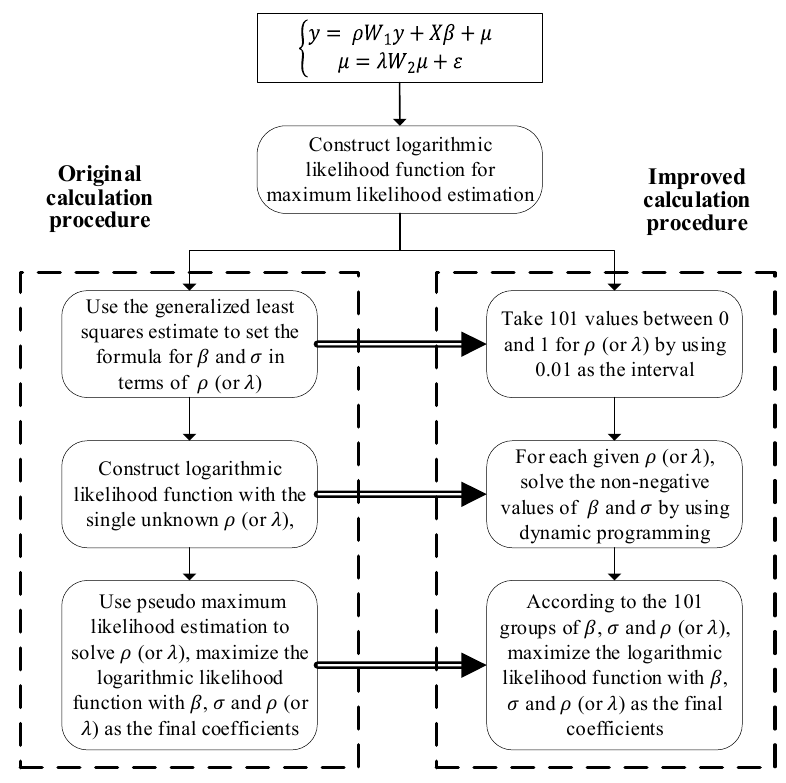
Figure 4. Original and improved calculation procedure of spatial autoregressive model.